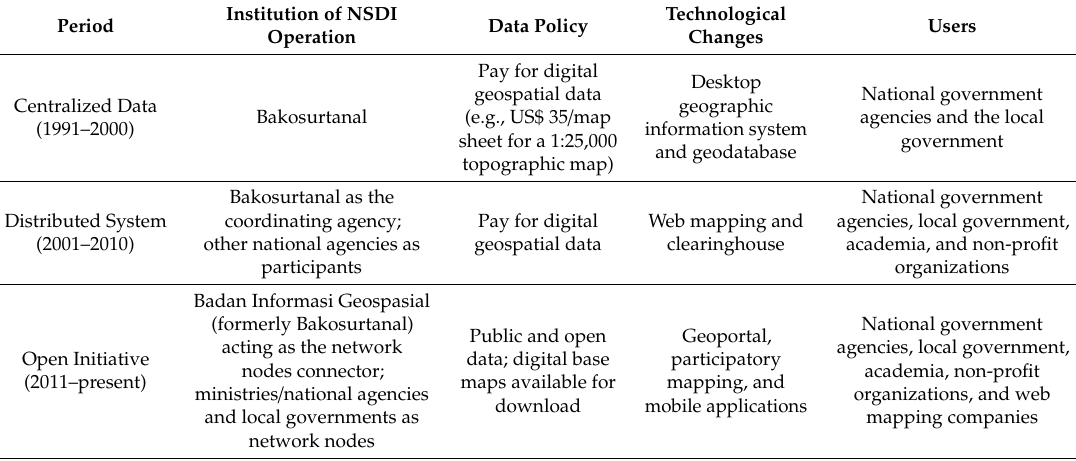
Table 1. Periods of national spatial data infrastructure (NSDI) development in